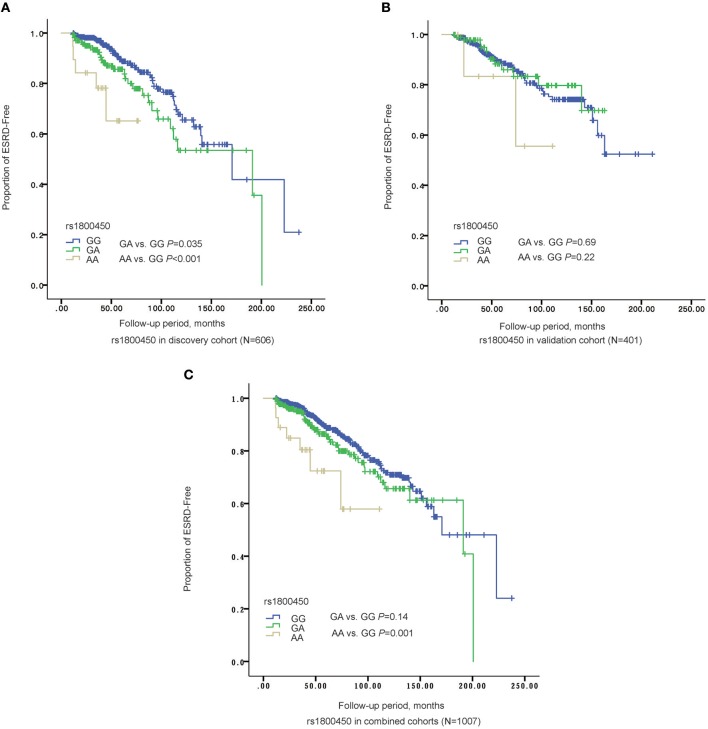
The Renal survival of different genotypes of rs1800450 in different cohorts. (A) In discovery stage (N = 606), AA group (mean ± SD: 60.0 ± 7.5 months, P = 0.035) had a significant shorter renal survival time than GA (mean ± SD: 140.0 ± 9.6 months, P < 0.001) and GG groups (mean ± SD: 161.6 ± 10.3 months); (B) In validation cohort (N = 401), AA group (mean ± SD: 85.9 ± 14.4 months, P = 0.22) had a significant shorter renal survival time than GA (mean ± SD: 139.1 ± 6.2 months, P = 0.69) and GG groups (mean ± SD: 161.4 ± 7.1 months); (C) In the combined cohorts (N = 1,007), AA group (mean ± SD: 82.4 ± 9.0 months, P = 0.14) had a significant shorter renal survival time than GA (mean ± SD: 150.5 ± 6.9 months, P = 0.001) and GG groups (mean ± SD: 167.7± 7.2 months).